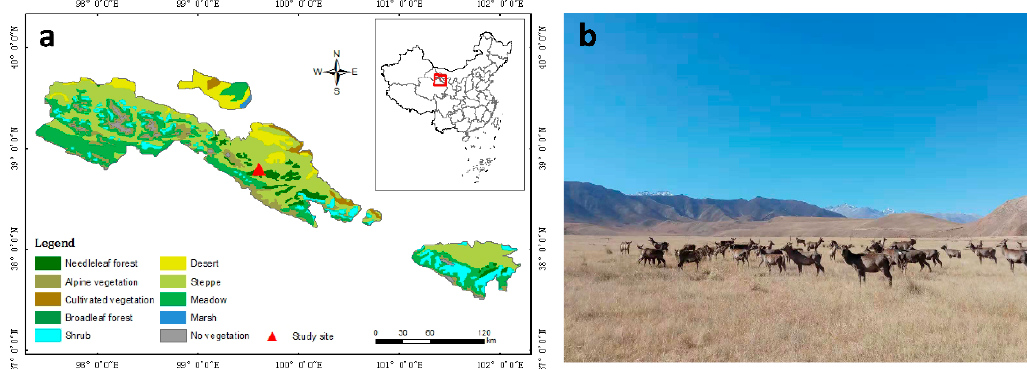
Figure 11. Map of study site. ( a ) Location of study site in Sunan County, the middle part in northern slope of the Qilian Mountains; ( b ) The grazing land and Gansu wapiti ( Cervus elaphus kansuensis ).